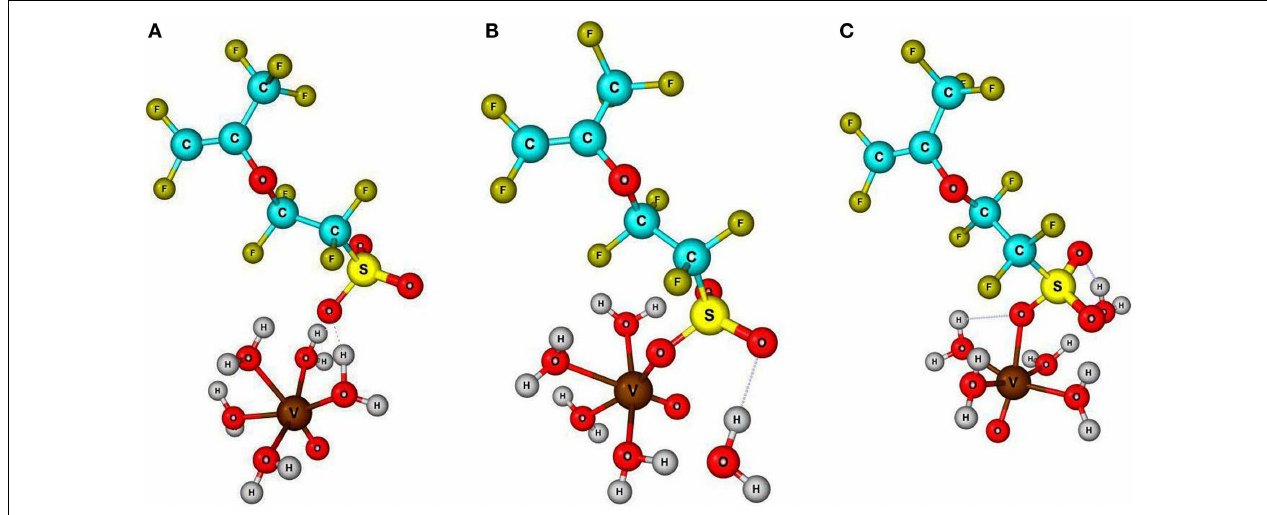
FIGURE 1 | Schematic view three possible interaction mechanisms, namely (A) solvent share, (B) contact pair through cis position, (C) contact pair through trans position, between solvated vanadyl ion with sulfonic acid sites inside the Nafion pores based on DFT analysis . Fully optimized molecular structures are available in Supplementary